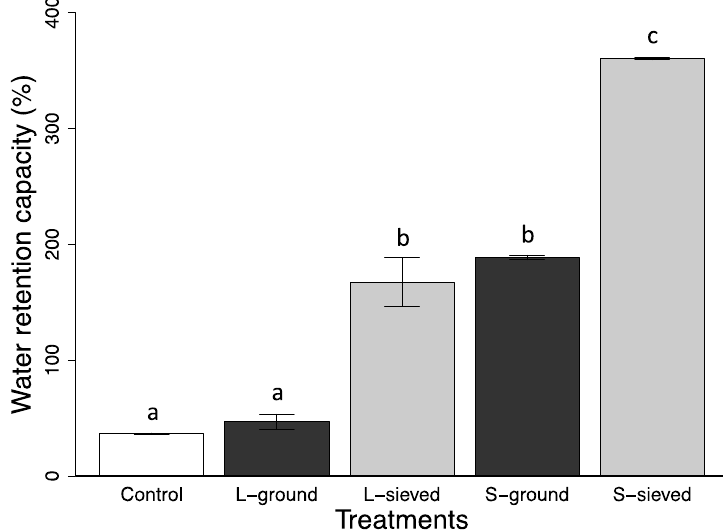
Figure 5. Water retention capacity of pure biochar by treatment and pure sand. Means are plotted ± 1 SE based on triplicate measurements within each treatment.